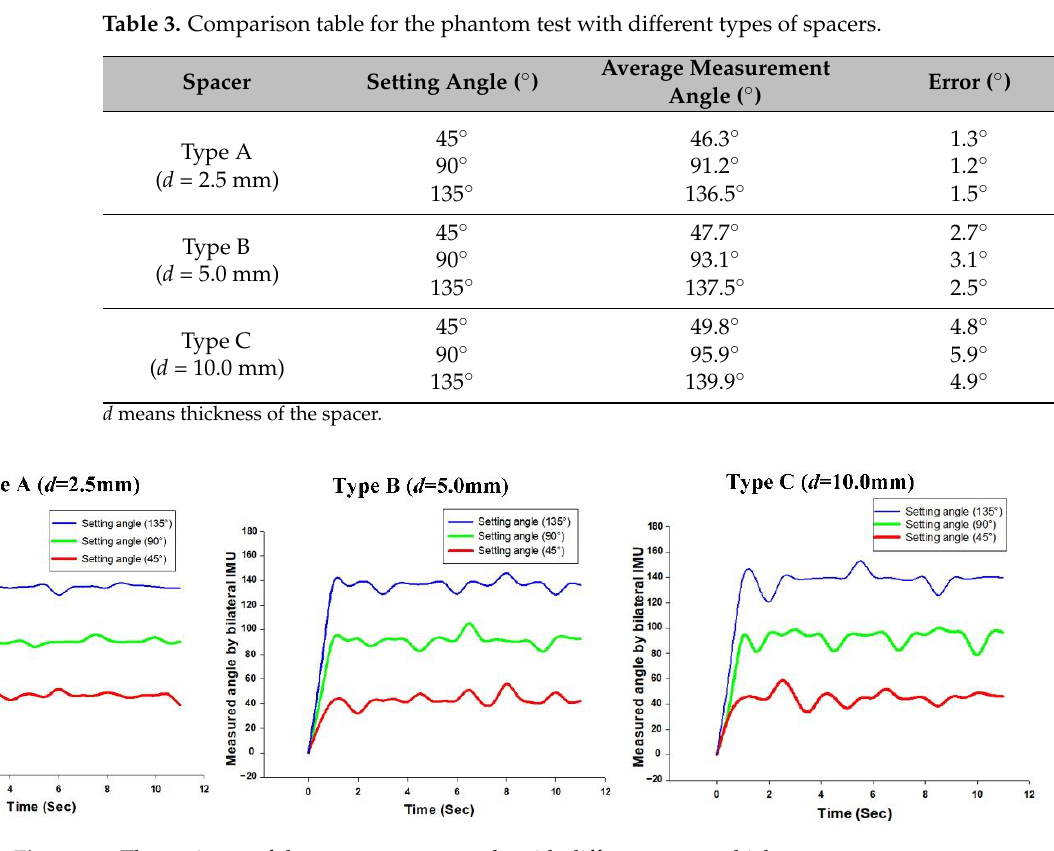
Figure 10. The variance of the measurement angle with different spacer thicknesses.